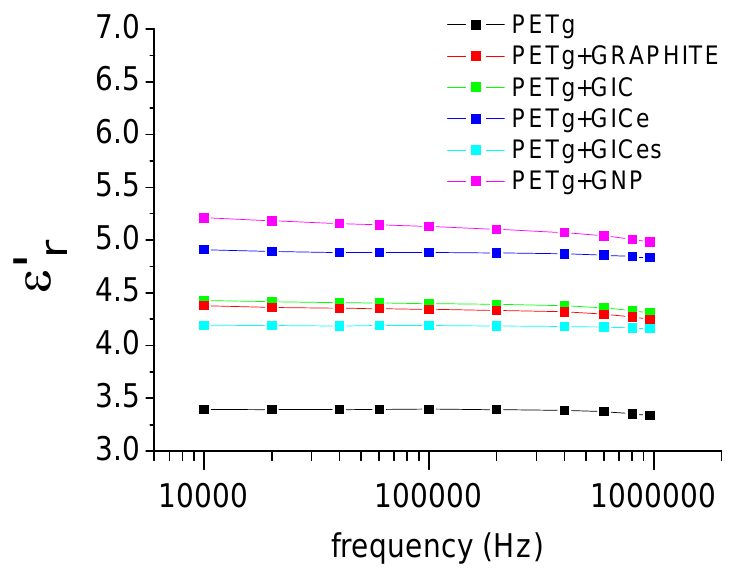
Figure 8. Dielectric constants of PETg